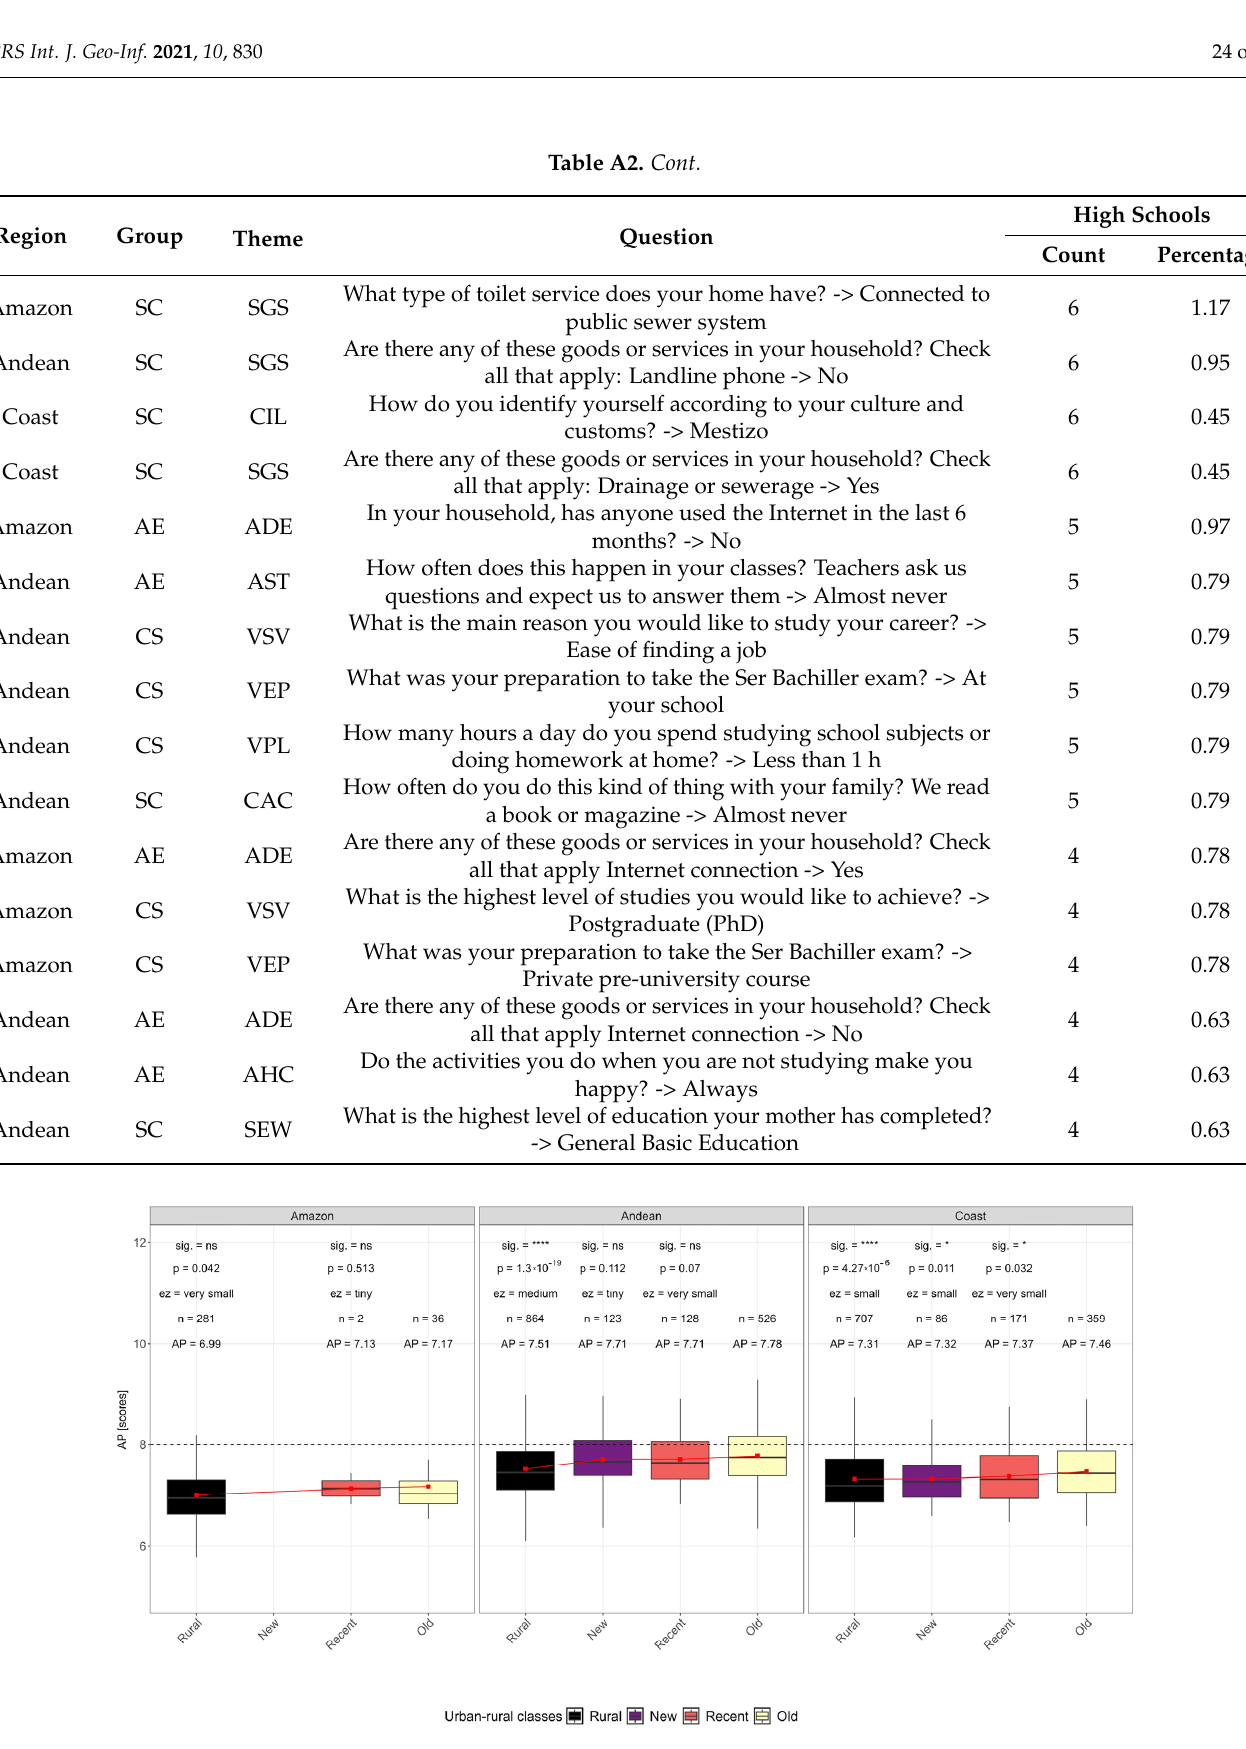
Figure A2. Boxplots using original AP scores for each urban–rural gradient map class and region. The text in the plots refers to the results of the Wilcoxon–Mann–Whitney test, showing significance ( 𝒔𝒊𝒈. ), p -values ( 𝒑 ), effect sizes ( 𝒆𝒛 ), sample sizes ( 𝒏 ), and mean AP scores ( 𝑨𝑷(cid:3364)(cid:3364)(cid:3364)(cid:3364) ). Red lines indicate the mean values. Outliers are hidden to facilitate visualization.